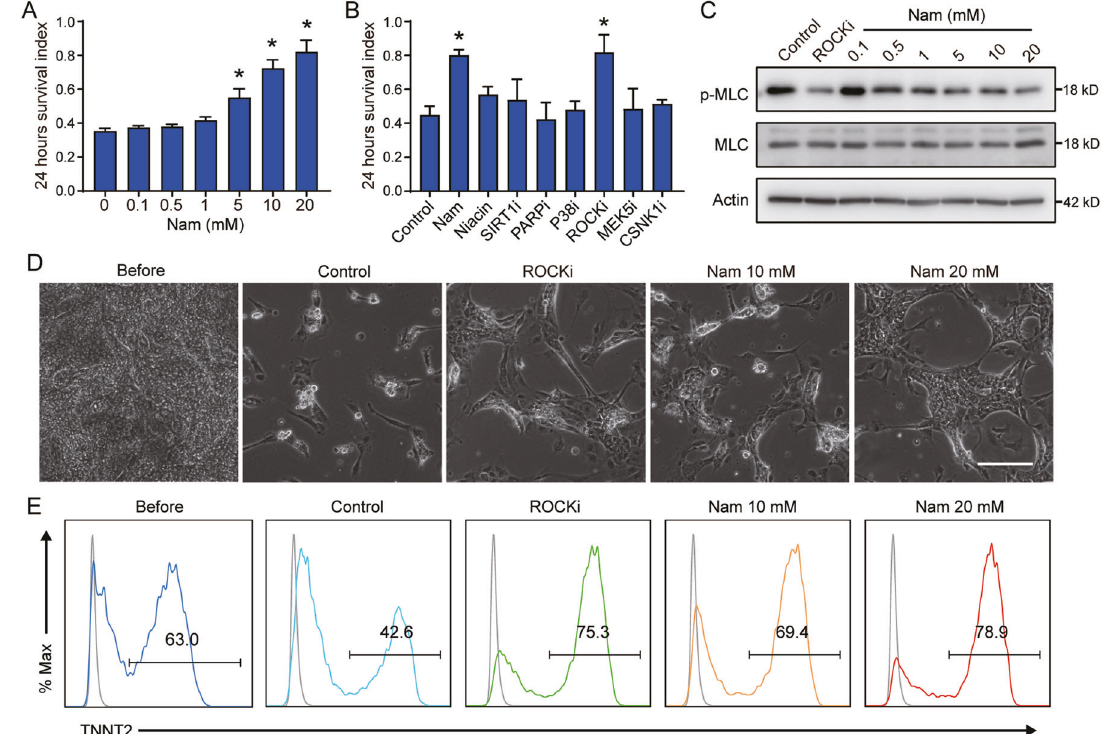
Fig. 6 Nicotinamide promotes the survival of hESC-derived cardiomyocytes and improves cardiomyocyte purity. A Dose-dependent impact of nicotinamide on the survival of hESC-derived cardiomyocytes. After 10 days of differentiation, hESC-derived cardiomyocytes were passaged under the indicated doses of nicotinamide (Nam). The survival index indicates the number of living cells divided by the input cells after 24 h of plating. B The effect of different modulators related to nicotinamide on cardiomyocyte survival 24 h after dissociation. Nicotinamide (Nam) 20 mM, Niacin 20 mM, EX527 (SIRT1i) 10 μ M, AZD2281 (PARPi) 100 nM, SB202190 (P38i) 10 μ M, Y-27632 (ROCKi) 10 μ M, BIX02189 (MEK5i) 5 μ M or D4476 (CSNK1i) 10 μ M. C Phosphorylation of MLC (Ser19) in dissociated cardiomyocytes under indicated doses of nicotinamide or ROCK inhibitor (Y27632, 10 μ M) treatment for 1 h after individualization. D Representative phase-contrast images of cardiomyocytes passaged under the indicated treatments, 24 h after plating. Nicotinamide (Nam) 10 mM or 20 mM, Y27632 (ROCKi) 10 μ M. Scale bar, 100 μ m. E Flow cytometric analyses showing the percentage of TNNT2-positive cardiomyocytes passaged under the indicated treatments, 24 h after plating. Data shown are normalized to control, and represent mean ± SD of three independent experiments (* p < 0.05 compared with